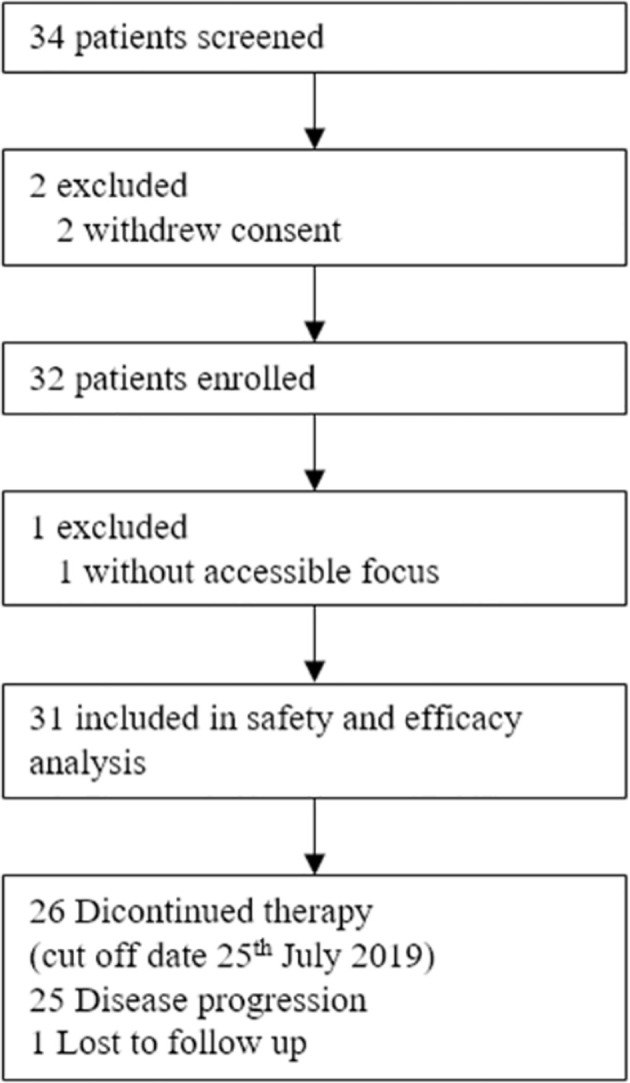
Clinical profile.